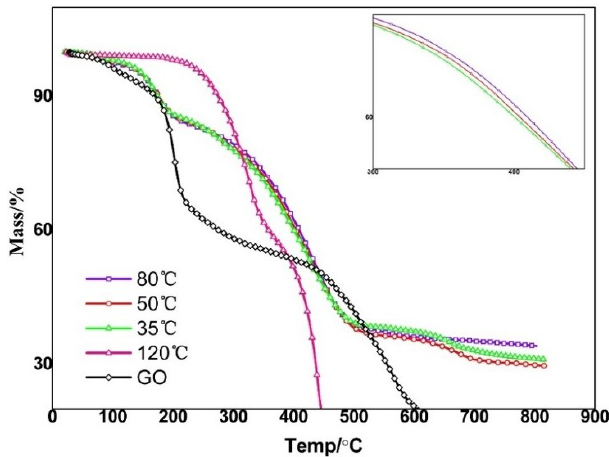
Figure 9. TGA of GO and RGO created at different temperatures.